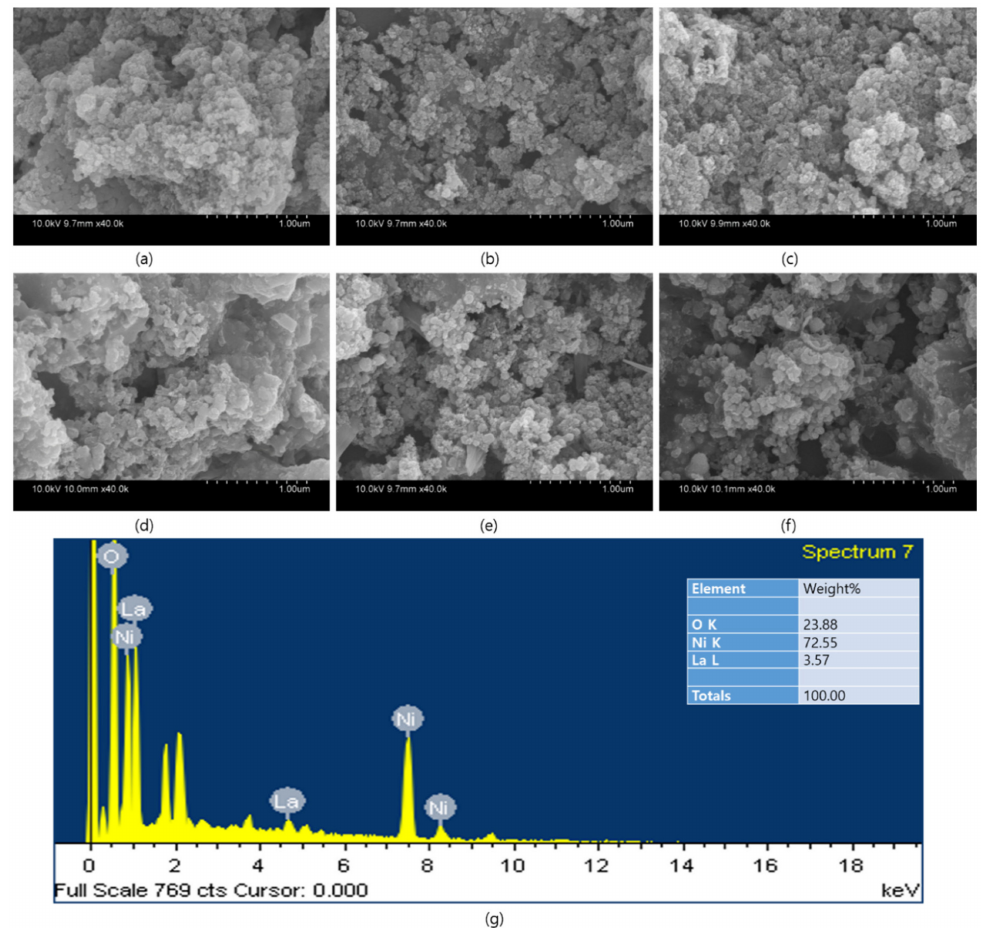
Figure 4. SEM images and EDS spectrum of prepared nanostructures ( a ) NiO, ( b ) NiO-La-02, ( c ) NiOLa-04, ( d ) NiOLa-06,